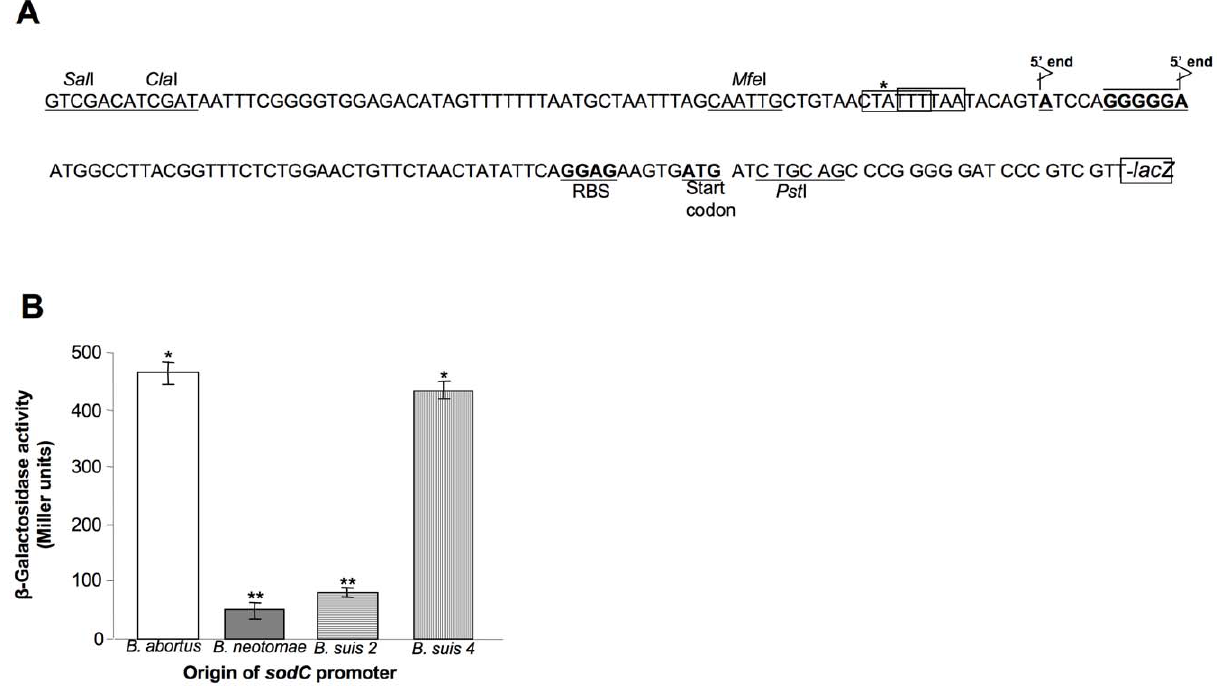
Figure 5. Evaluation of strength of sodC promoters from B.abortus , B.neotomae , B.suis biovars 2 (strain Thomsen) and 4 (strain 40). A) Nucleotide sequence features of the promoter-containing 5 9 flanking region of B. abortus sodC gene as cloned in pBaSODpro/lacZ. The sodC start codon, ribosomal binding site (RBS), and 5 9 ends of cDNA are indicated in bold. The asterisk indicates the site of nucleotide insertion polymorphism with B. neotoame and B. suis biovars. The two potential 2 10 sequences are boxed (see Discussion). B) Expression levels of b -galactosidase in late log phase cultures of B. neotomae cultures harboring plasmids with lacZ gene cloned under the control of sodC promoters obtained from the indicated Brucella spp. For each promoter construct, the assays were performed using 3 separate colony cultures. Results are shown as the mean 6 standard deviation of Miller units. Means with the same number of asterisks were not significantly different from each other ( P . 0.05). There were significant differences between means with different number of asterisks ( P ,